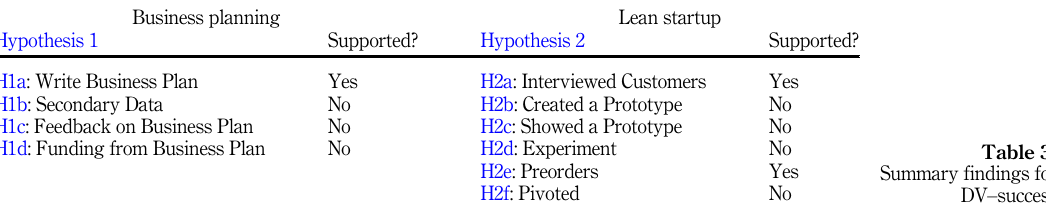
Table 2. Summary regression